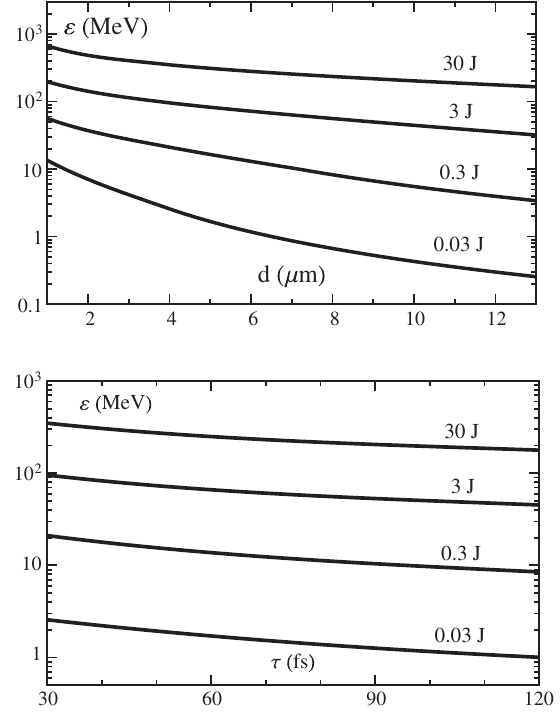
120 FIG. 5. Maximum proton energy as a function of the laser spot size d (top panel) and as a function of the pulse duration (bottom panel) for a hydrogen foil of n e ¼ 200 n cr and optimum thickness. for the laser pulse duration of τ ¼ 30 fs. The bottom panel shows maximum proton energy as the function of laser ffiffiffiffiffiffiffiffiffiffiffiffiffiffiffiffiffiffiffi p 1 þ ð a Þ 2 − 1 (cid:2) , where a ence [14], T 0 ∝ mc 2 ½ 1 1 is the laser a ¼ a 1 0